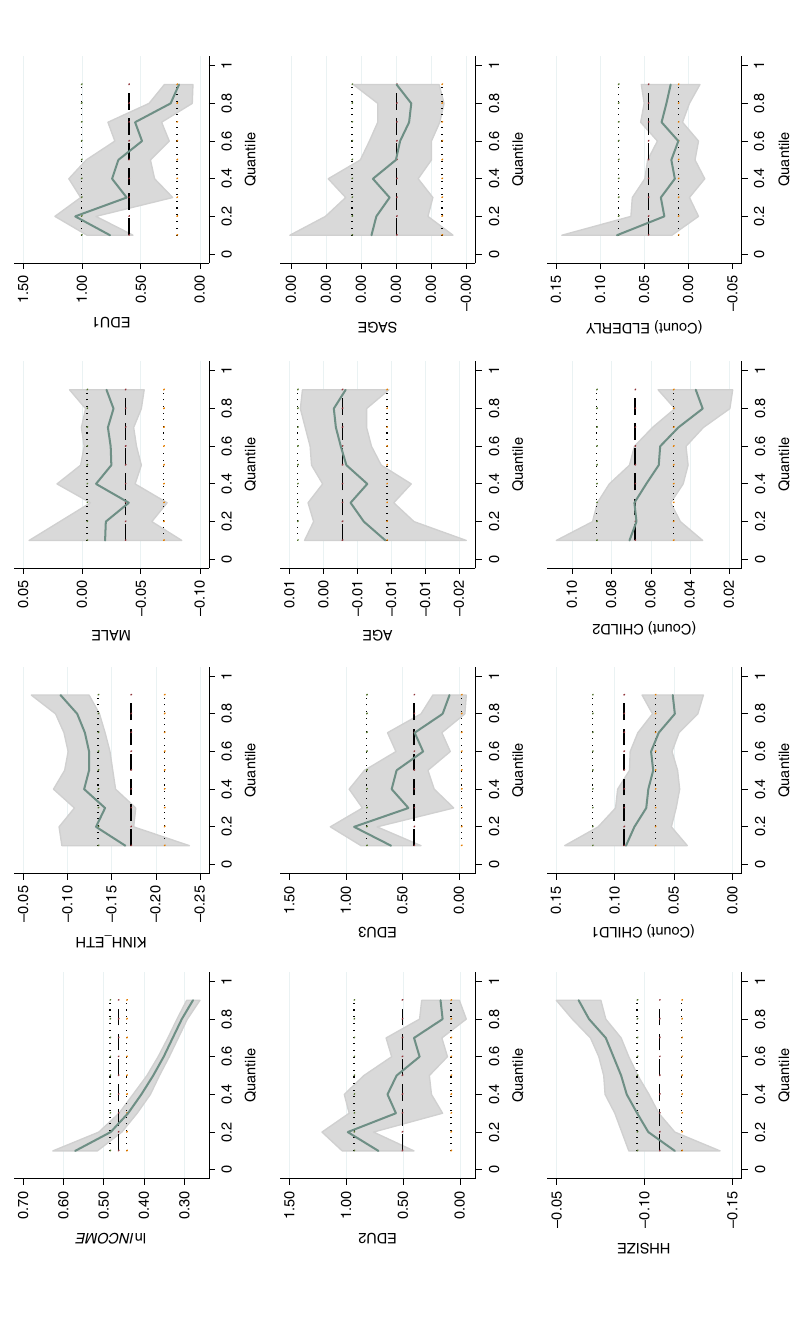
Figure 5. Ordinary least squares regression and quantile regression estimates for Vietnamese household saving rate in rural